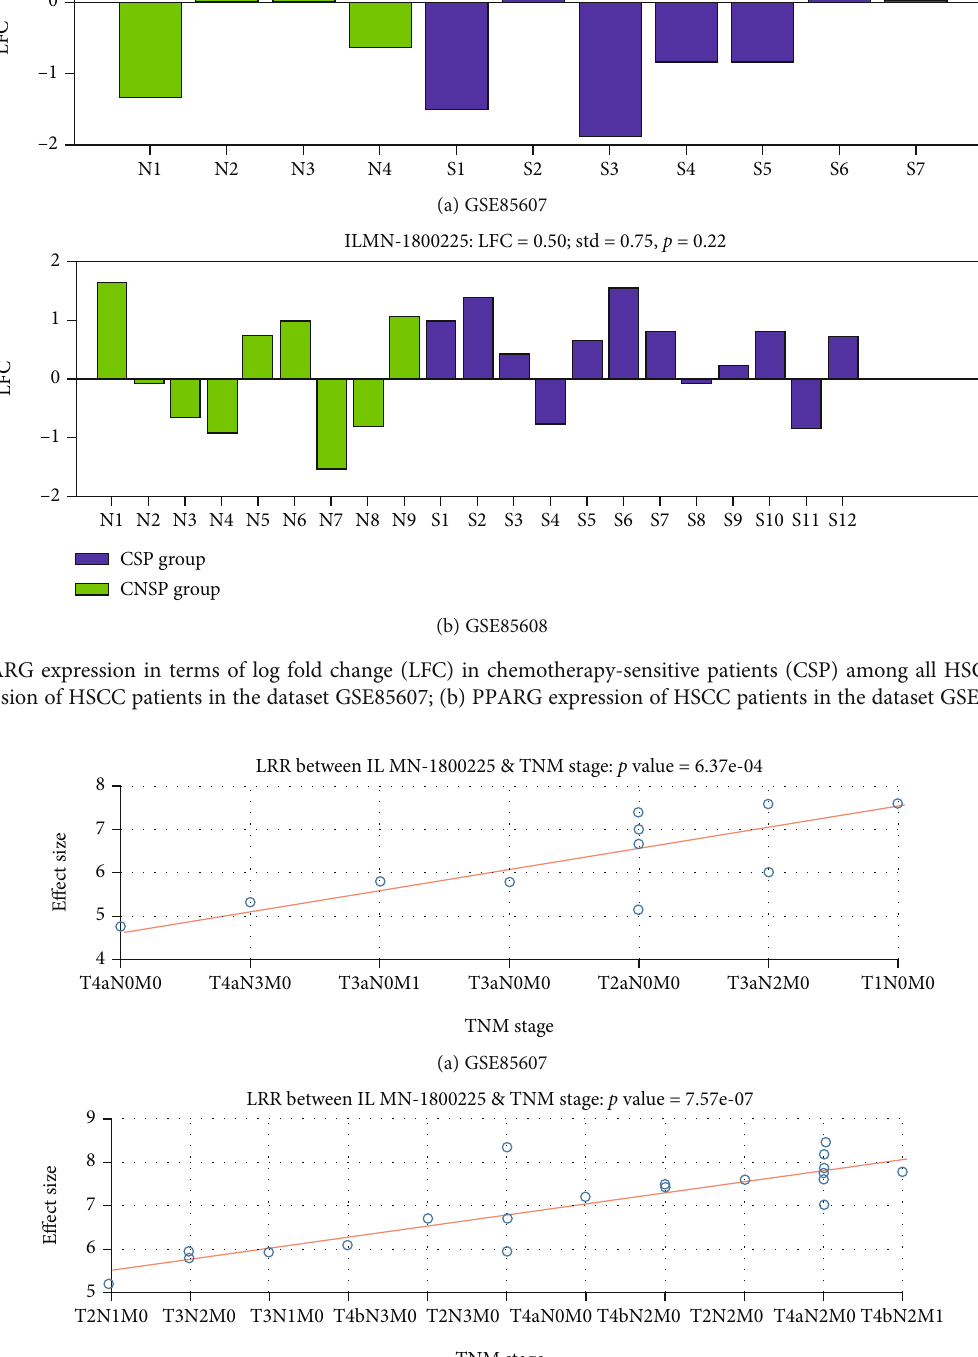
Figure 2: Association between PPARG expression and TNM stage in HSCC patients: (a) association plot by using data of HSCC patients in the dataset GSE85607; (b) association plot by using data of HSCC patients in the dataset GSE85608. The expression levels were log2- transferred.